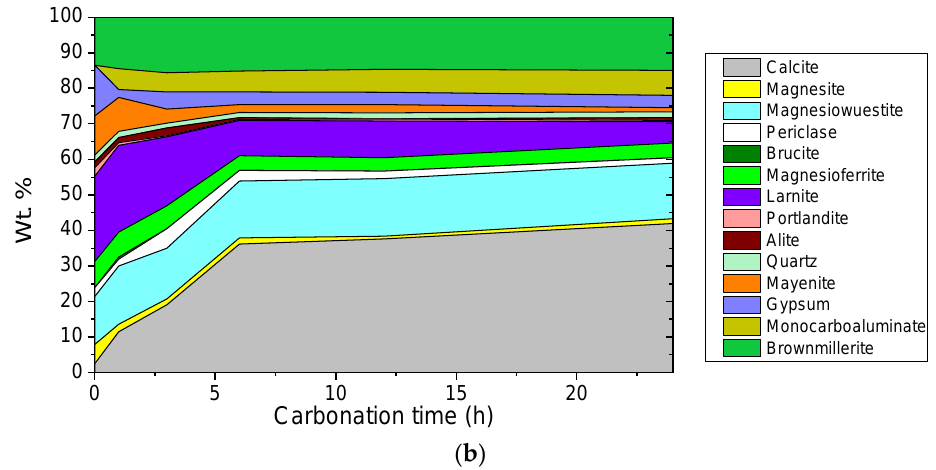
Figure 8. UCS and CO 2 uptake results ( a ) and semi-QXRD analyses results ( b ) of 27 MPa molding pressure samples with different curing times.